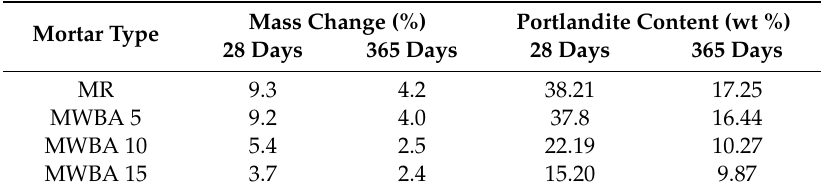
Table 9. TG mass change and Portlandite content.